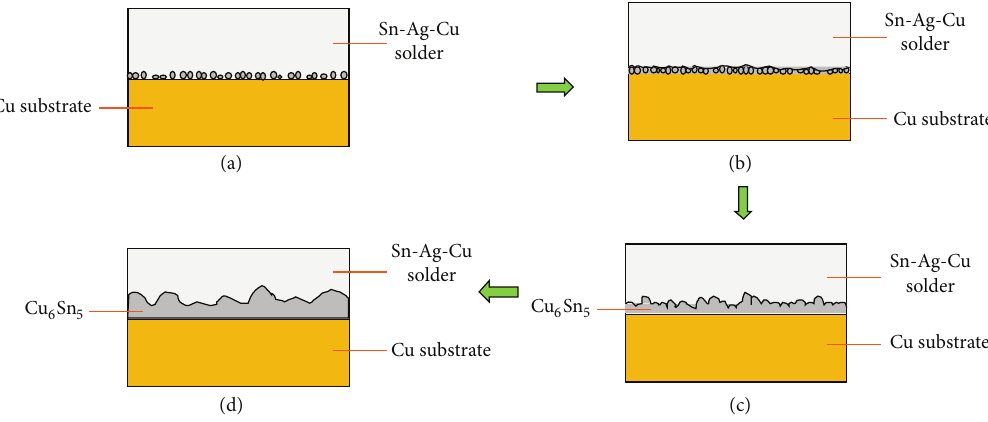
Figure 8: Schematic diagram of the growth mechanism of Cu 6 Sn 5 at the Sn-Ag-Cu/Cu interface: (a) individual Cu 6 Sn 5 grains at the interface, (b) Cu 6 Sn 5 growth along the interface, (c) the ripening process resulted in scallop Cu 6 Sn 5 , and (d) coarsening of scallop Cu 6 Sn 5